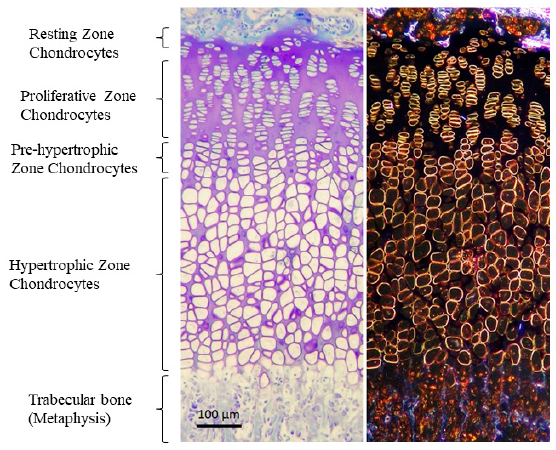
Figure 1. Structure of the GP stained with Toluidine blue in bright field ( left ) and phase contrast ( right ). Four zones are distinguished: (1) germinal or resting zone, which serves as a reservoir for cells and nutrients; (2) proliferative zone or zone of active growth, where chondrocytes proliferate and divide, forming columns oriented in the direction of growth; (3) hypertrophic zone, which is the second zone of active growth, in this case not due to proliferation but due to an increase in the size of cells. Chondrocytes here increase in size due to water entry and protein synthesis, and begin to form a matrix that will later be digested by osteoclasts and calcified by osteoblasts; (4) ossification zone, where the hypertrophic chondrocytes that have reached their maximum size die, leaving a space or lagoon that will be calcified by the osteoblasts, or they can also differentiate into osteoblast. Vascular invasion is also critical for the correct arrival of nutrients, factors, osteoblasts and osteoclasts to the calcification area. Micrographs from the author’s